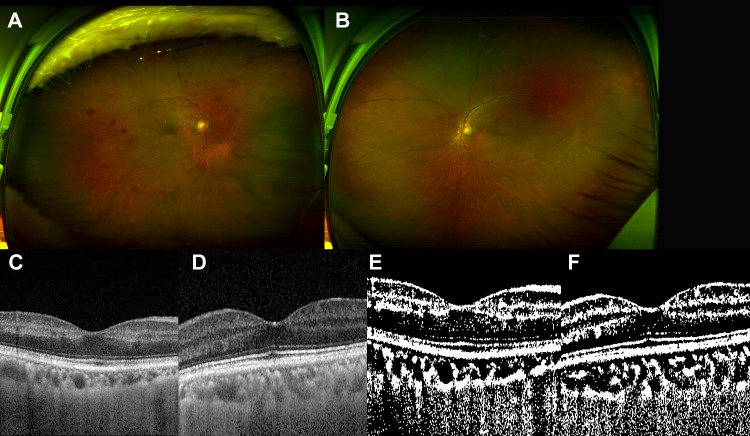
The 63-year-old male patient with ocular ischemic syndrome in the right eye.He had past history of hypertension and myocardial infaction. (A and B) (A) Multiple blot retinal hemorrhages were noted in the right eye, whereas (B) there was no significant finding in the left eye. (C and D) Spectral domain optical coherence tomography showed inner retinal thinning in the right eye (C), whereas normal foveal contour in the left eye (D). The mean subfoveal choroidal thickness by spectral optical coherence tomography was 99.0 μm in the right eye and 201.5 μm in the left eye. (E and F) After binarization, (E) the choroidal area was 316,100.2 μm2 and the luminal area was 212,300.2 μm2 in the right eye. (F) The choroidal area was 516,100.3 μm2 in the left eye and the luminal area was 348,400.5 in the left eye.